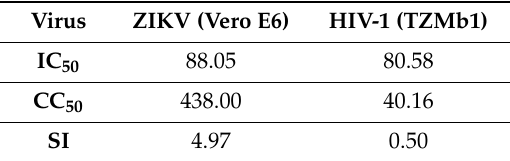
Table 4. Values of the 50% cytotoxic concentration (CC 50 ), half maximal inhibitory concentration (IC 50 ) and selectivity index (SI).